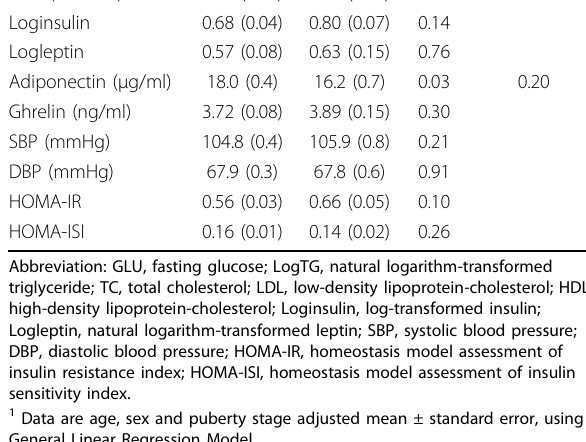
and obesity 1 Overweight and obesity Obesity